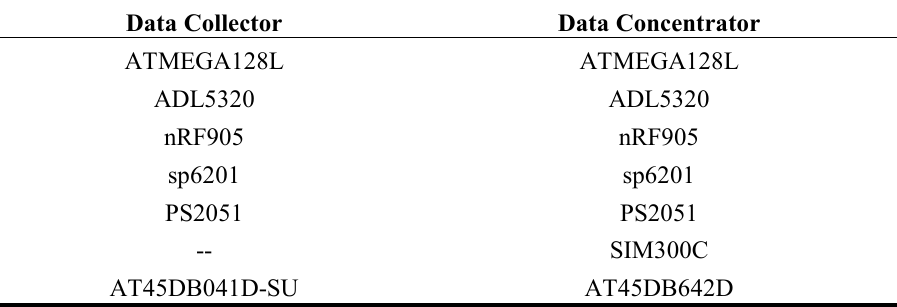
Table 5. Elements used in EMMNet.